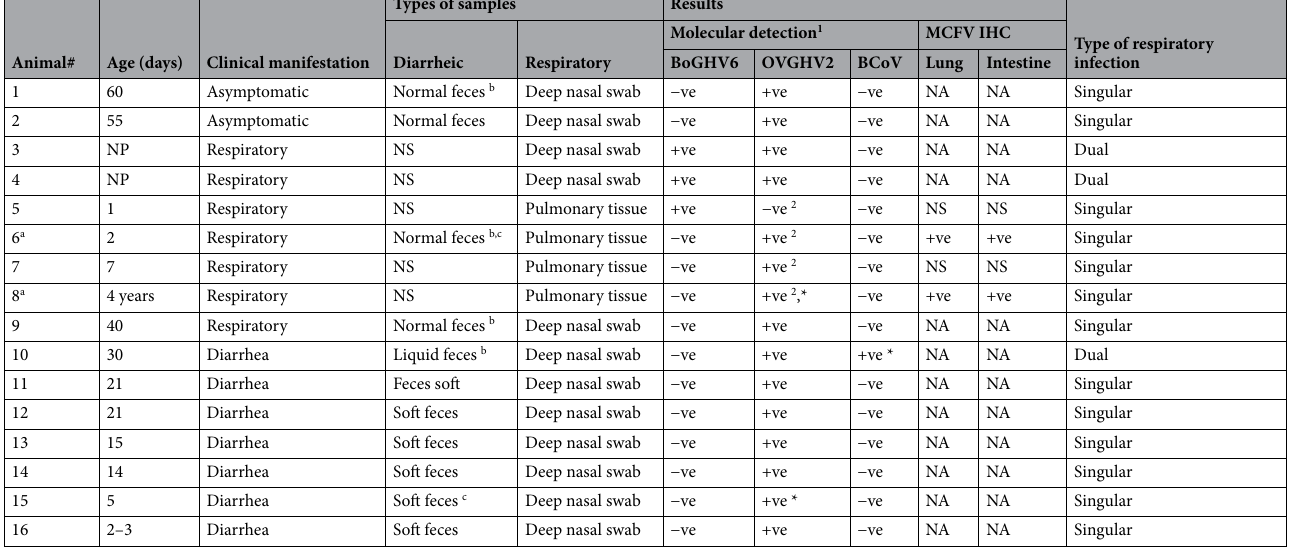
Table 1. Molecular and immunohistochemical findings observed in asymptomatic calves and in cattle with respiratory and enteric manifestations. *Sequenced samples. a Animals that died of pulmonary distress